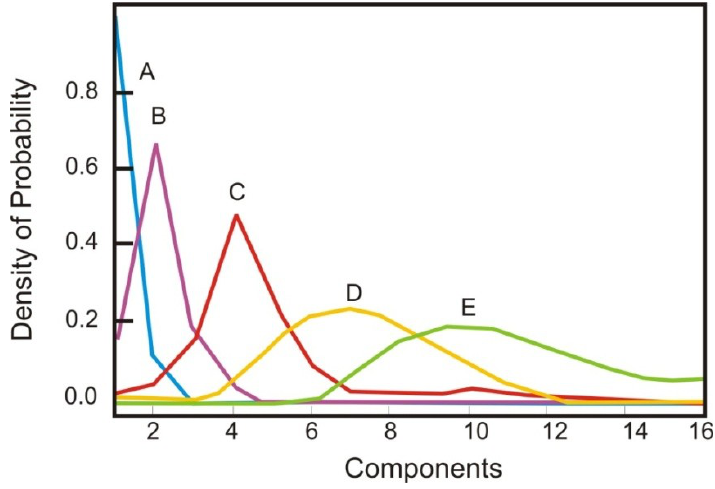
Figure 11. Probability density signatures in the study area (A, B, C, D and E